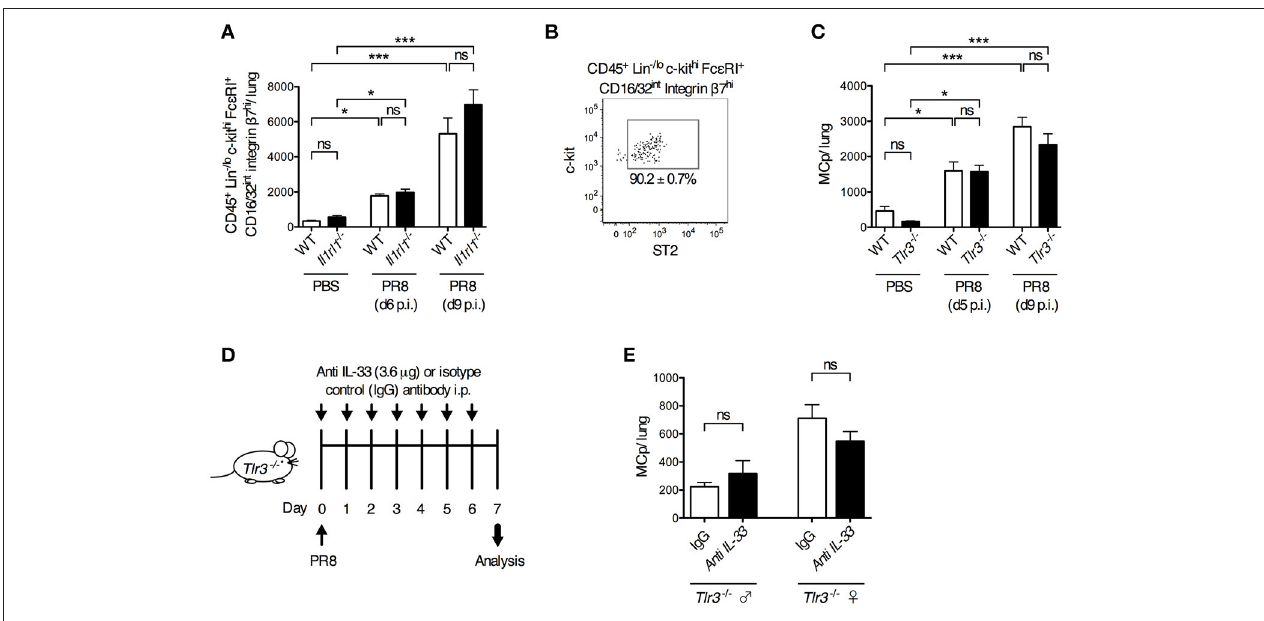
FIGURE 4 | ST2- and TLR3-mediated signals are dispensable for influenza-induced recruitment of MCp to the lung . Il1rl1 − / − or Tlr3 − / − mice and their wild type (WT) littermates were infected with PR8 influenza virus or given PBS. (A) The total number of CD45 + Lin − / lo c-kit hi Fc ε RI + CD16/32 int integrin β 7 hi cells per mouse lung using the gating strategy shown in Supplementary Figure 4 . The data are pooled from four independent experiments, three analyzed day 6 post-infection (d6 p.i.) and one analyzed d9 p.i. ( n = 9–10 mice PBS-treated, n = 6–15 PR8-infected). (B) The majority of the CD45 + Lin − / lo c-kit hi Fc ε RI + CD16/32 int integrin β 7 hi cells from WT mice are ST2 + . (C) The total number of MCp per lung. The data are pooled from four independent experiments, two analyzed d5 p.i. and two analyzed d9 p.i. ( n = 4–10 PBS-treated, n = 9–13 PR8-infected). The data in (A) and (C) are expressed as mean ± SEM and analyzed by one-way ANOVA with Tukey’s multiple comparisons test. ns = no significant difference. (D–E) Tlr3 − / − mice were given anti-IL-33 or polyclonal normal goat IgG i.p. 2h before infection and daily from day 1 to day 6 post-influenza infection. (E) The total number of MCp per lung assessed on day 7 post-influenza infection. The data are pooled from two